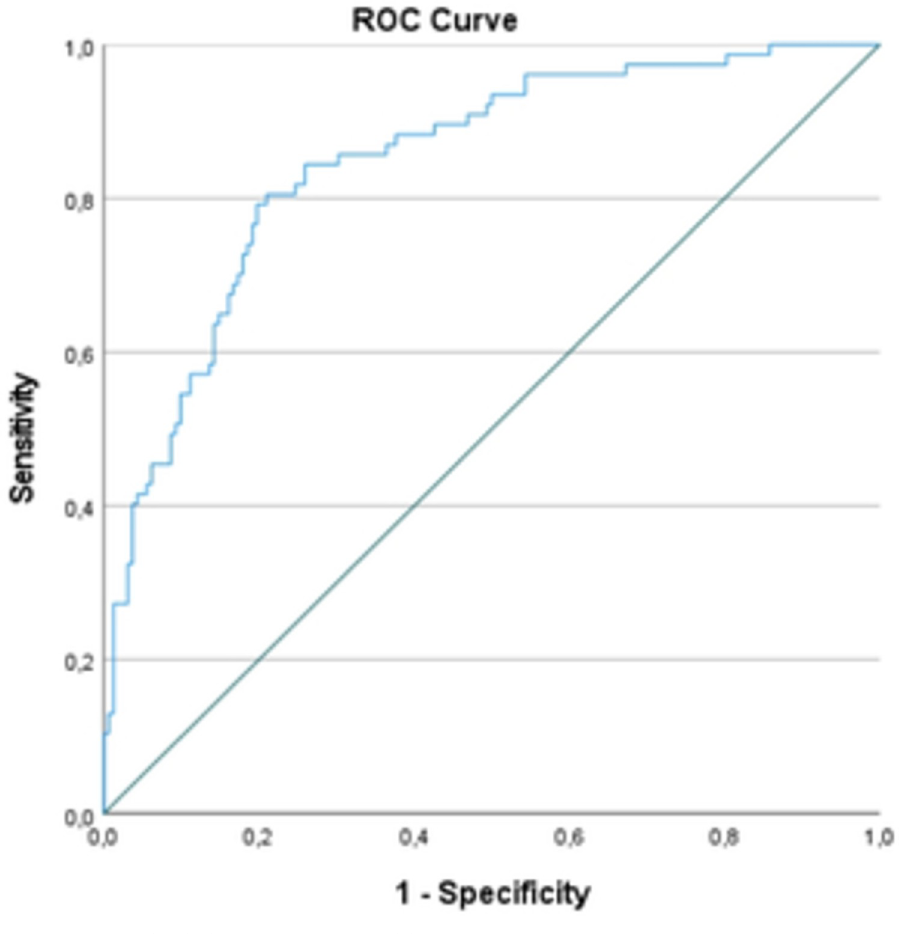
Fig 2. ROC curve for the logistic regression